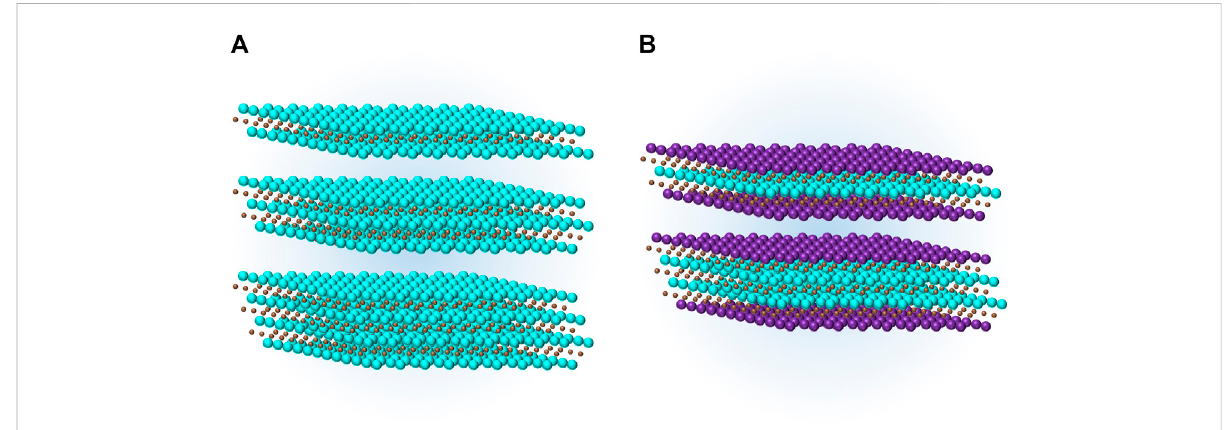
FIGURE 2 (A) The structure of MXenes with different formula: M 2 X, M 3 X 2 , and M 4 X 3 . (B) Two new families of MXenes, ordered double transition metal carbides with M